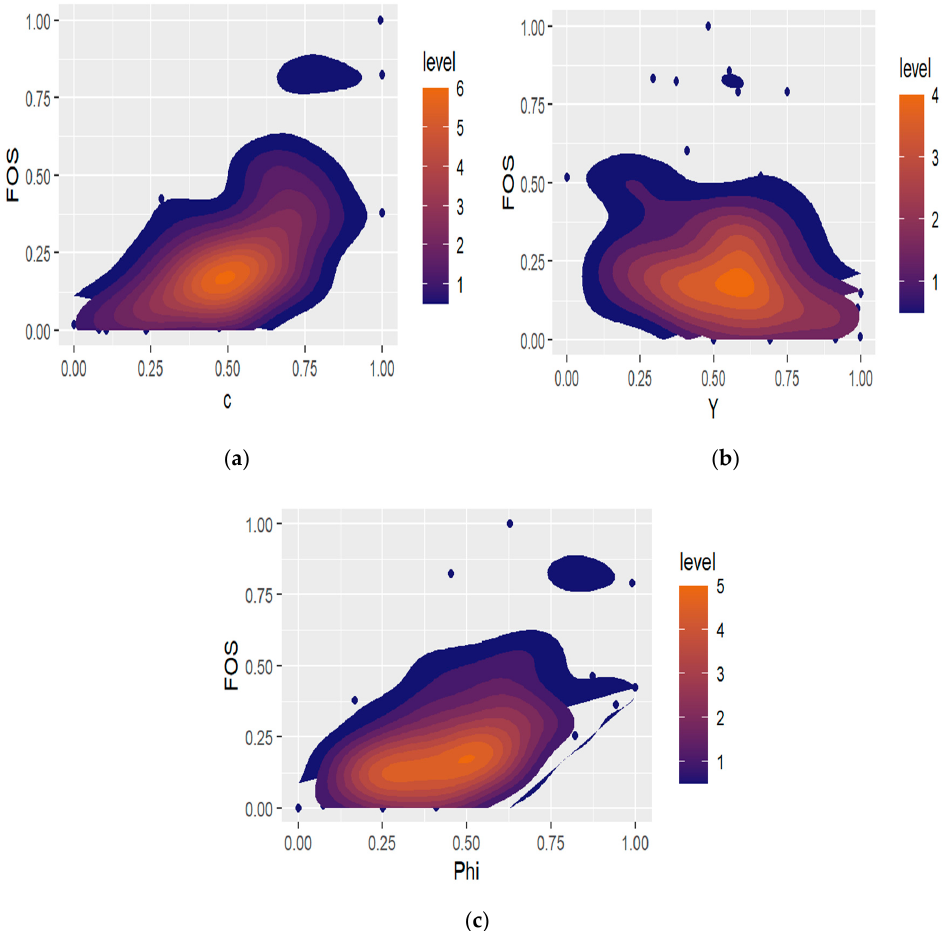
Figure 4. Scatter plot among input parameters ( a ) c and FOS; ( b ) ϒ and FOS and ( c ) φ and FOS (variables are in normalized form).